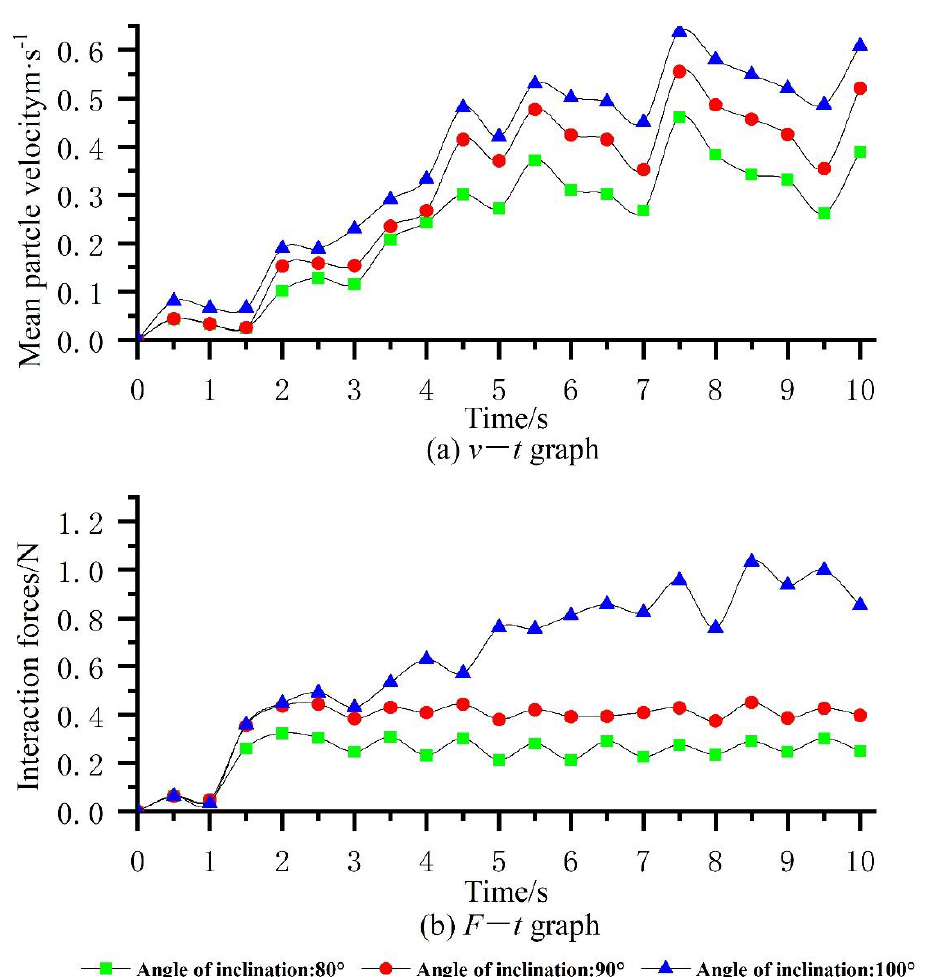
Figure 11. Average velocity and interaction force curves of tea particles at different pot slot angles of inclination.